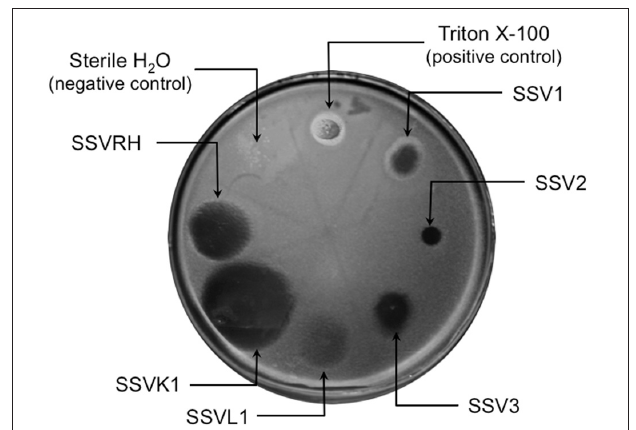
FIGURE 2 | SSV-strain specific halo formation on Sulfolobus solfataricus strain G θ by all six SSV tested strains. Virus susceptibility is determined by the production of halos of growth inhibition around a 1.0 μ L spot of virus concentrate applied to a Gelrite (cid:2) softlayer containing S. solfataricus strain G θ . Locations of spots and identities of SSVs are indicated with arrows. Plate were incubated for 4 days at 78 ◦ C. Halo morphologies are typical for each SSV-strain. Triton X-100 and sterile H 2 O serve as positive and negative controls,